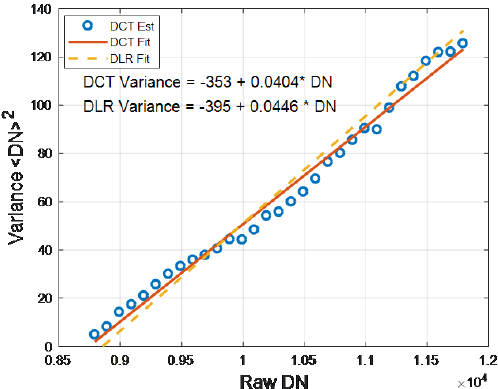
Figure 16. Mean–variance plot derived from a portion of the Sudan image acquired on 11 April 2019, showing agreement with ground-based